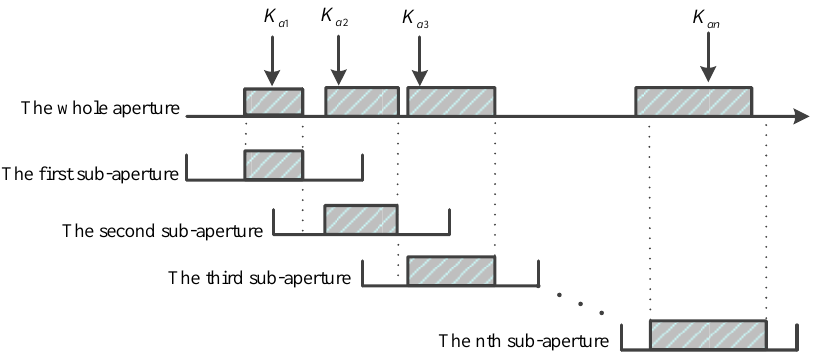
Figure 2. Schematic diagram of traditional spectrum fusion method.